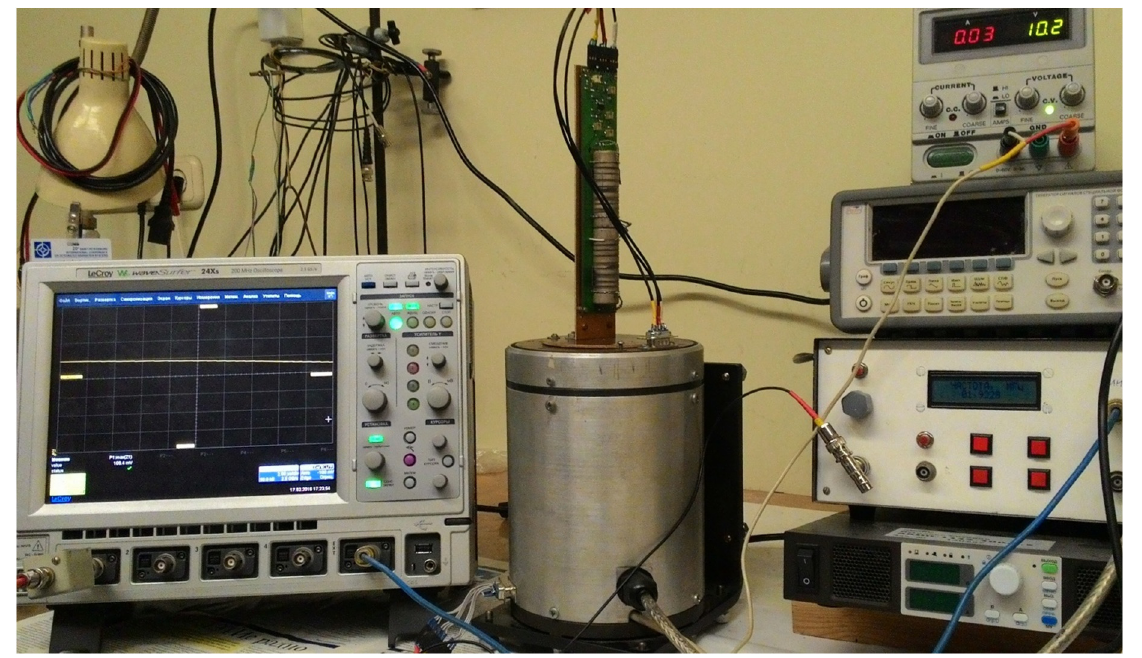
Figure 10. The RRS SE on CPAW.